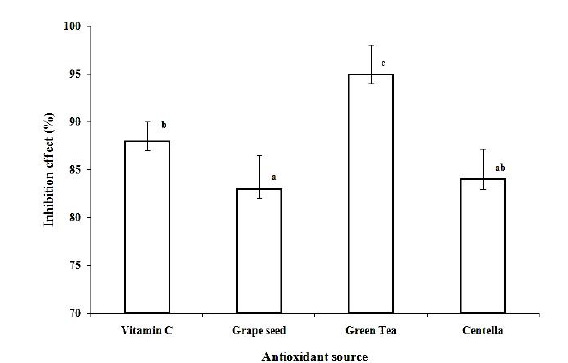
Figure 3. DPPH-radical scavenging activity of centella extract, grape seed, green tea and vitamin C at 1 mg/mL concentrations. Values are the mean ± SD (n = 3). Among the extracts studies, green tea shows the highest inhibition effect followed by vitamin C, Centella and grape seed extract. Values with different letter are significantly different at P < 0.05 .